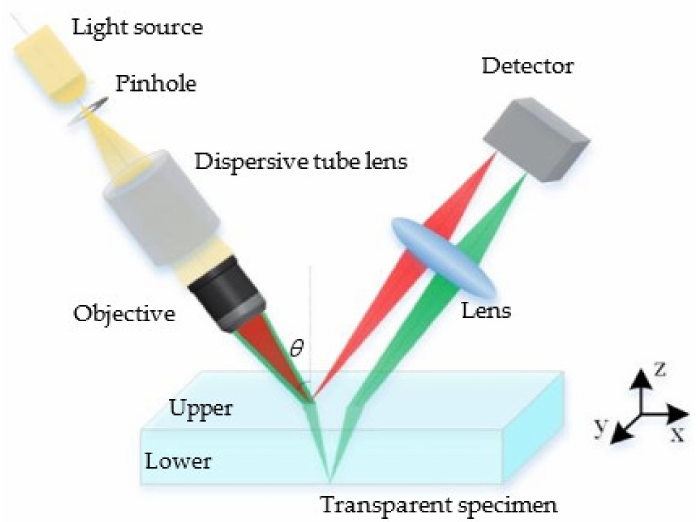
Figure 4. Principle of chromatic confocal with inclined